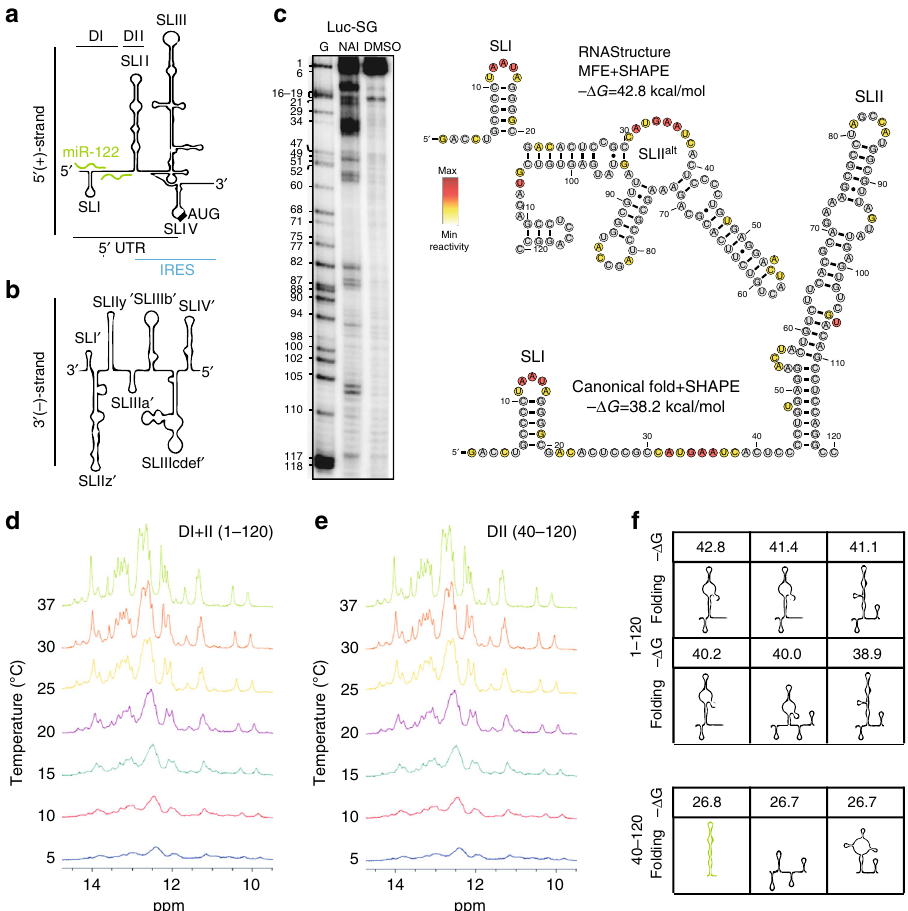
Fig. 3 Structural assessment of the HCV 5 ′ UTR. a Schematic overview of the HCV 5 ′ UTR and IRES. The miR-122-binding sites are indicated in green. Domain I and II are indicated above (DI and DII). b Schematic overview of the 3 ′ UTR of the negative strand RNA, which is complementary to the 5 ′ UTR of the positive strand. Note the divergence in secondary structures, which is due to the different function in replication (3 ′ (-)-strand) and translation (5 ′ ( + )-strand). c Representative autoradiography image showing the in vitro SHAPE reactivity of nucleotides 1 – 120 of a HCV reporter replicon. The SHAPE data were used to predict the secondary structure (minimum free energy, MFE) of DI and II with the RNA structure web tool and were visualized with R2R. The nucleotides of SLII alt are colored according to their respective normalized reactivity. Yellow and red colors indicate unpaired nucleotides. The SHAPE data are also shown in context of the canonical fold of DI + II. d , e RNA conformation of DI + II (nt 1 – 120) or DII alone (nt 40 – 120), monitored by 1D 1 H NMR spectra of imino protons in a temperature gradient. f Top conformations calculated by RNA structure and their respective free energy values ( − Δ G [kcal/mol]) for DI + II or DII